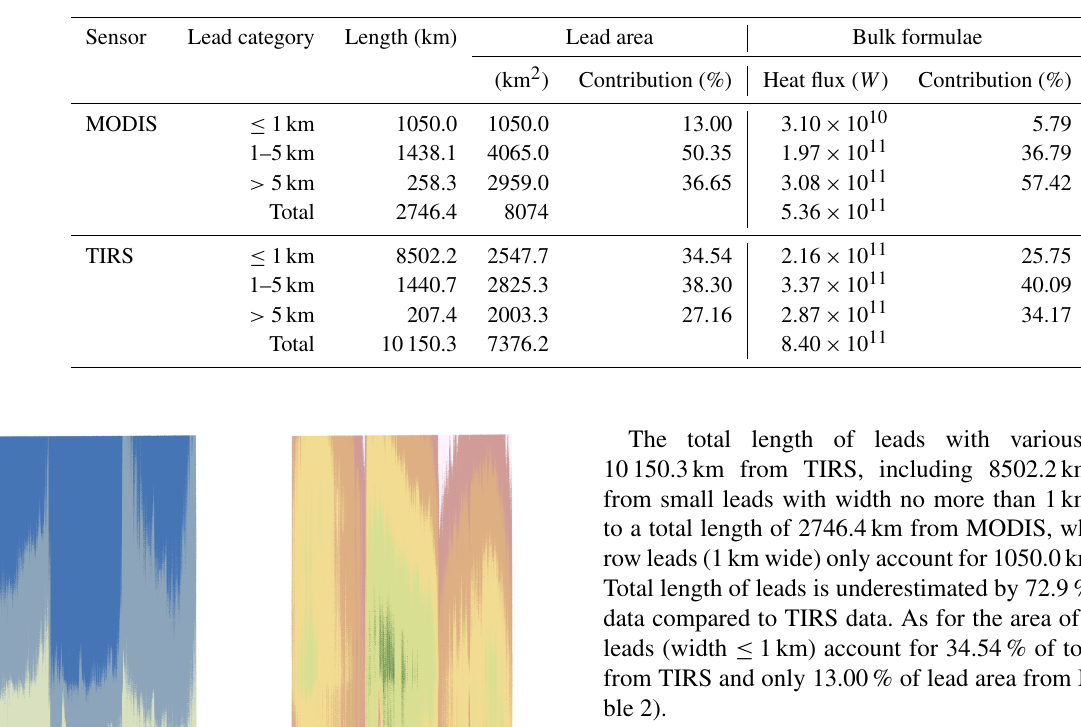
Table 2. Retrieved leads from MODIS and TIRS and turbulent heat flux estimated using bulk formulae.